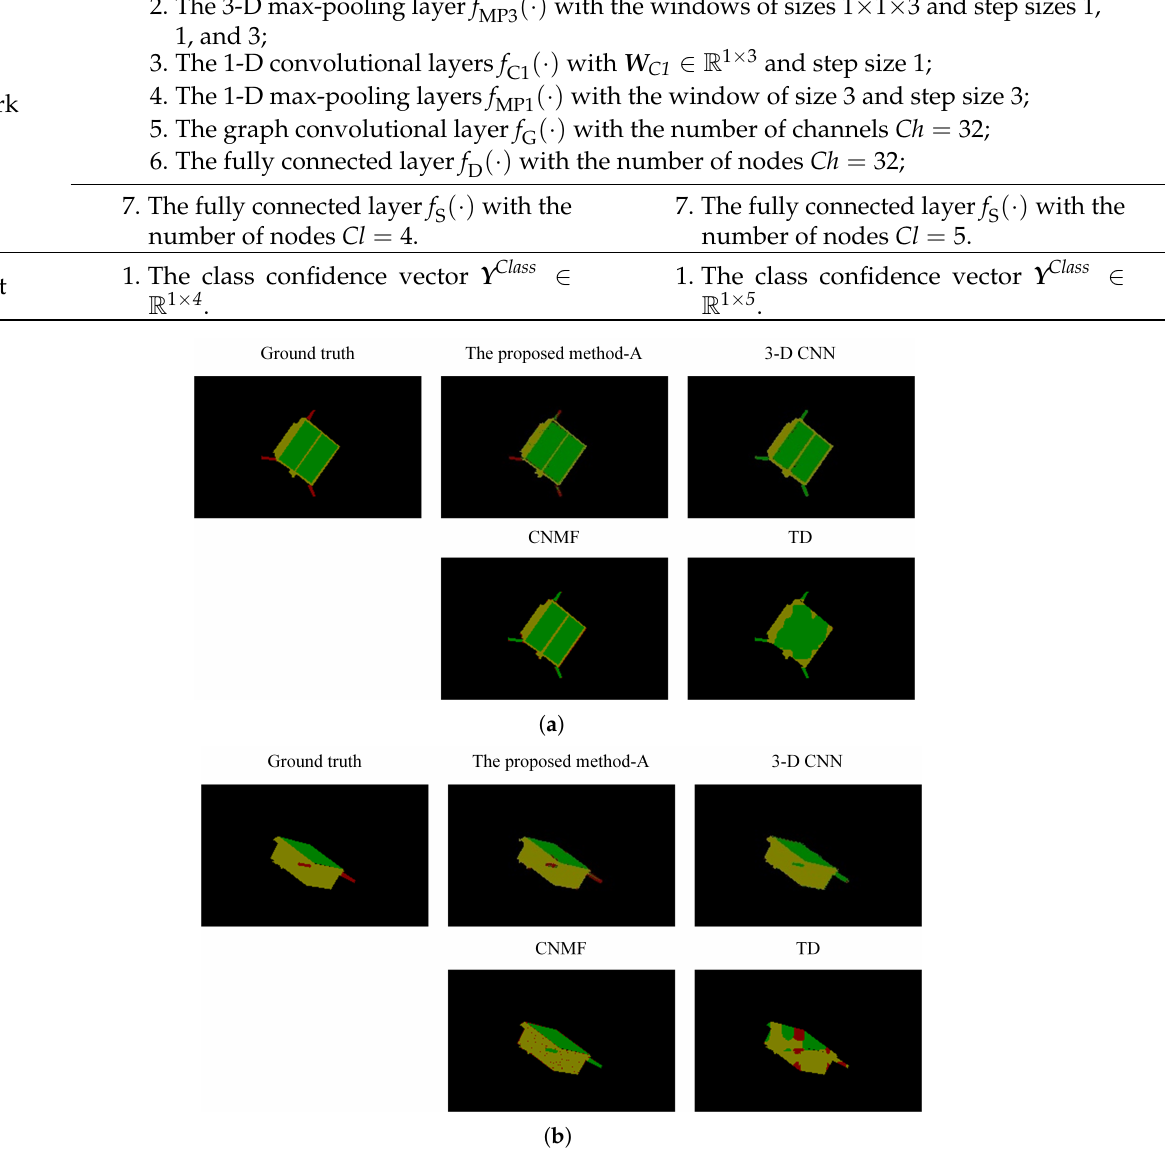
Figure 14. Examples of material identification results using the simulated data: ( a ) example